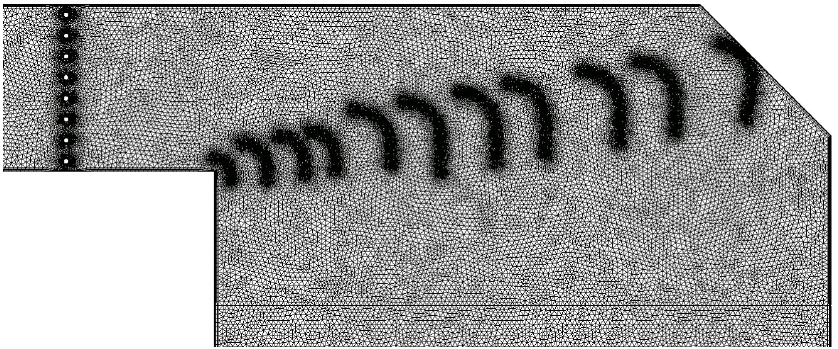
Figure 5. Computing procedure for AIG nozzle flow optimization.